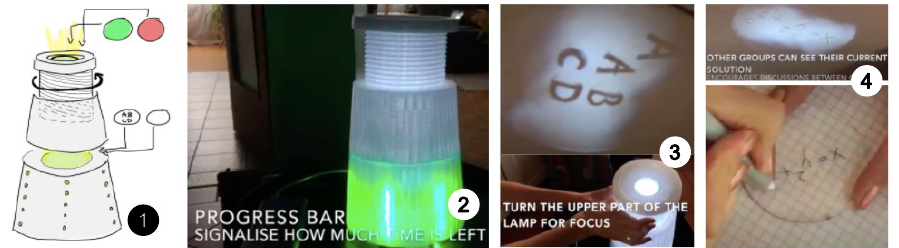
Figure 3. stayFOCUSed technical prototype ( 1 . concept idea and structure; 2 . show timer with light progress bar; 3 . rotate the lamp to show answers; 4 . pen-writing on the